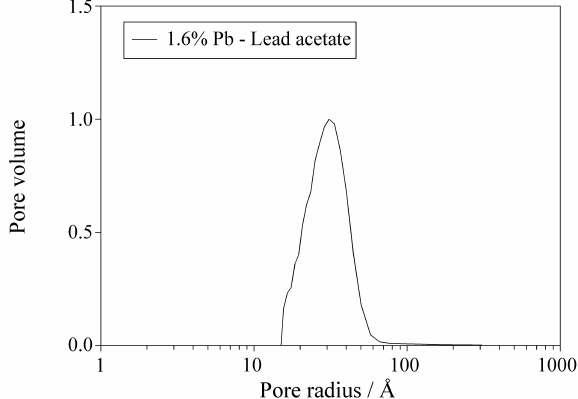
Figure 7. Pore size distribution of gel obtained via lead acetate heat treated at 105 °C (the weight of the sample was not considered, then volume scale is